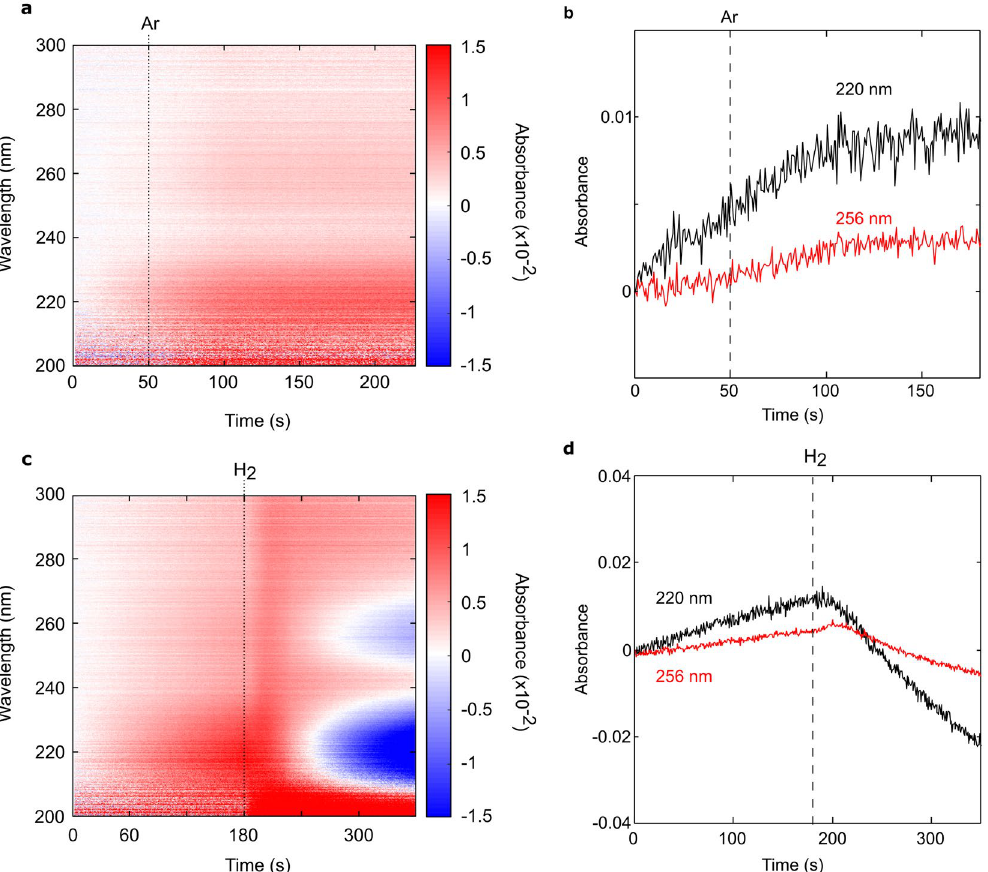
Figure 3. Absorbance spectra of pure argon and hydrogen at growth temperatures. ( a ) Time evolution of the absorbance and ( b ) line profiles of the 220 nm and 256 nm peaks for hydrogen, where the dotted line at 50 s denotes when hydrogen is added in vacuum; ( c ) Time evolution of the absorbance and ( d ) line profiles of the 220 nm and 256 nm peaks for Argon, where the line at 180 s denotes when argon is added in